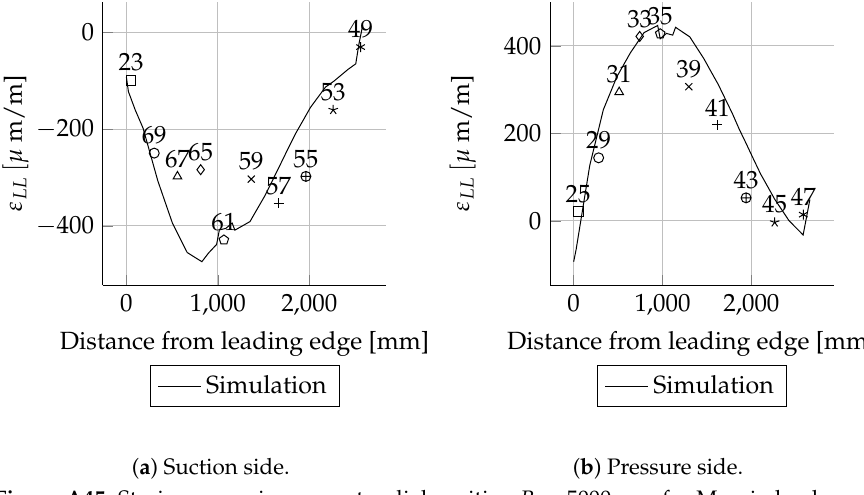
Figure A45. Strain comparison ε TT at radial position R = 5000 mm for Mymin load case.